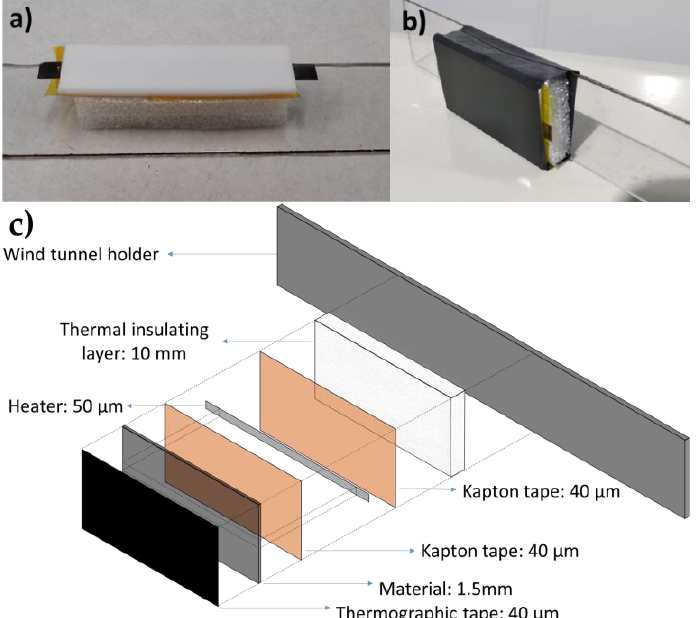
Figure 1. ( a ) PTFE testing block, from top to bottom: PTFE, Kapton tape, heating element, Kapton tape, Thermal insulating layer. ( b ) Thermographic tape covering the testing block. ( c ) Scheme of testing block.